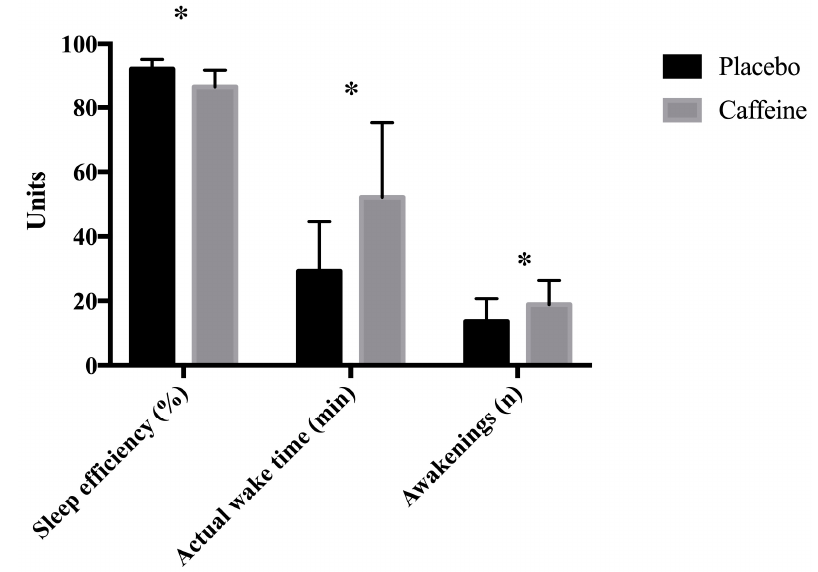
Table 2. Sleep quality results.